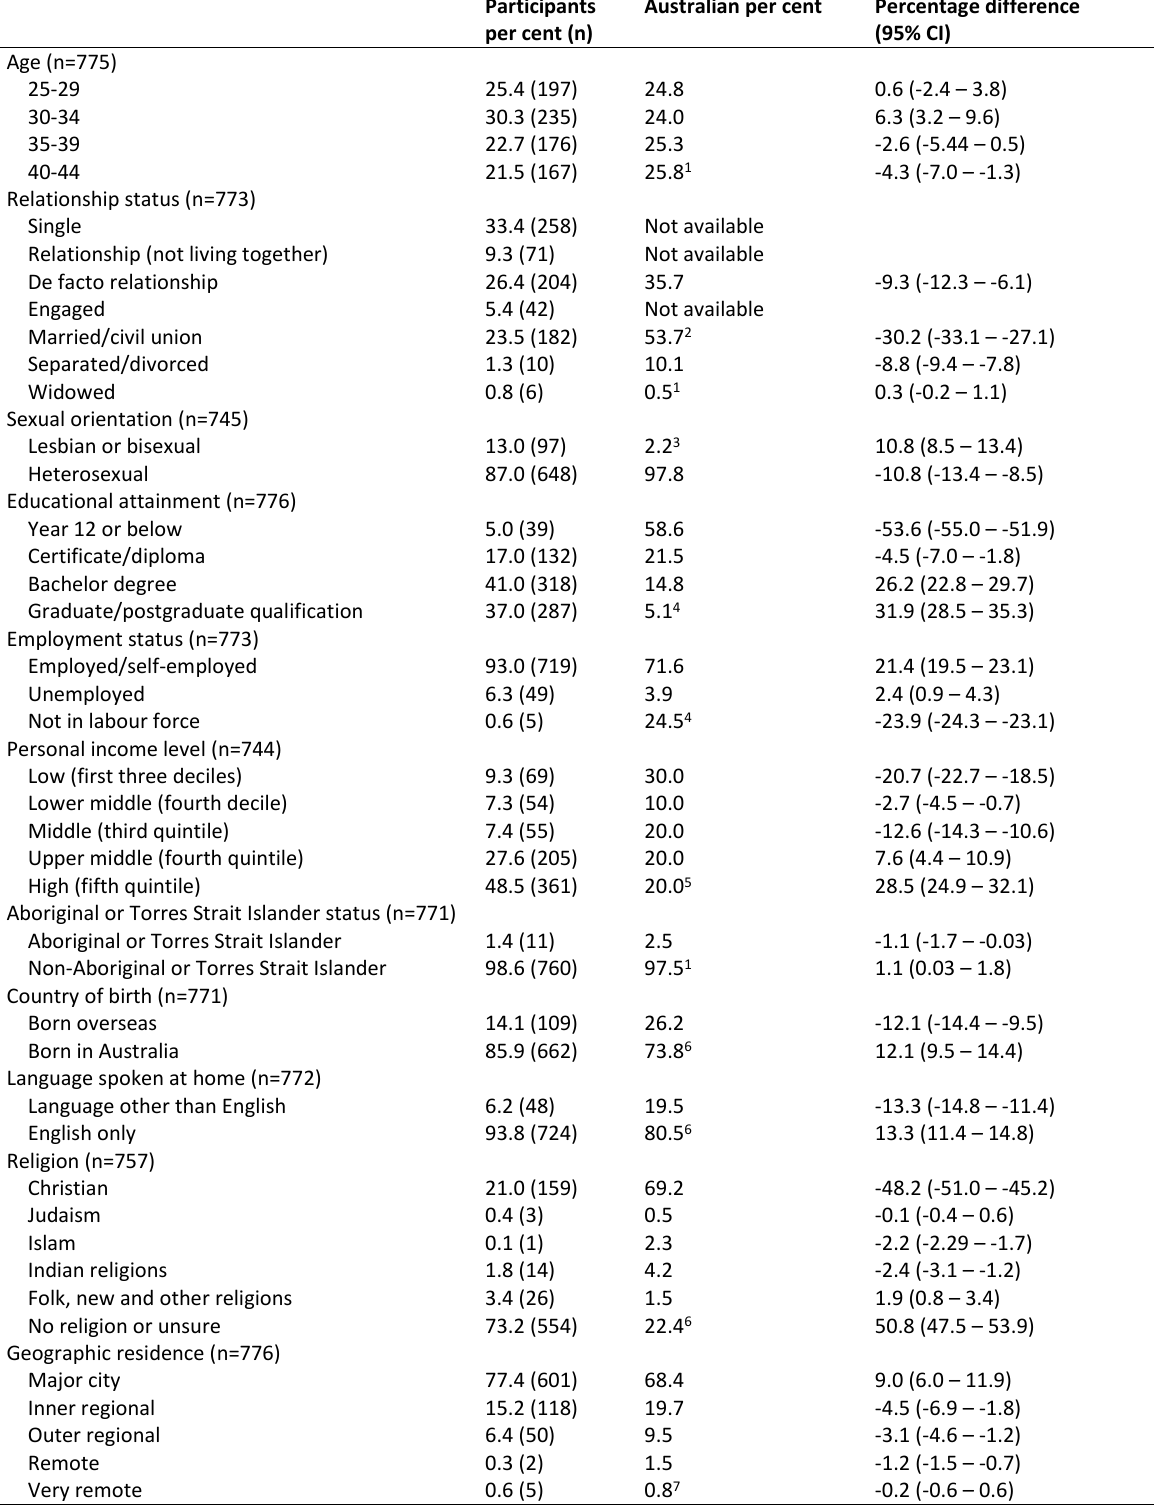
Table 1. Demographic characteristics of participants and comparable Australian